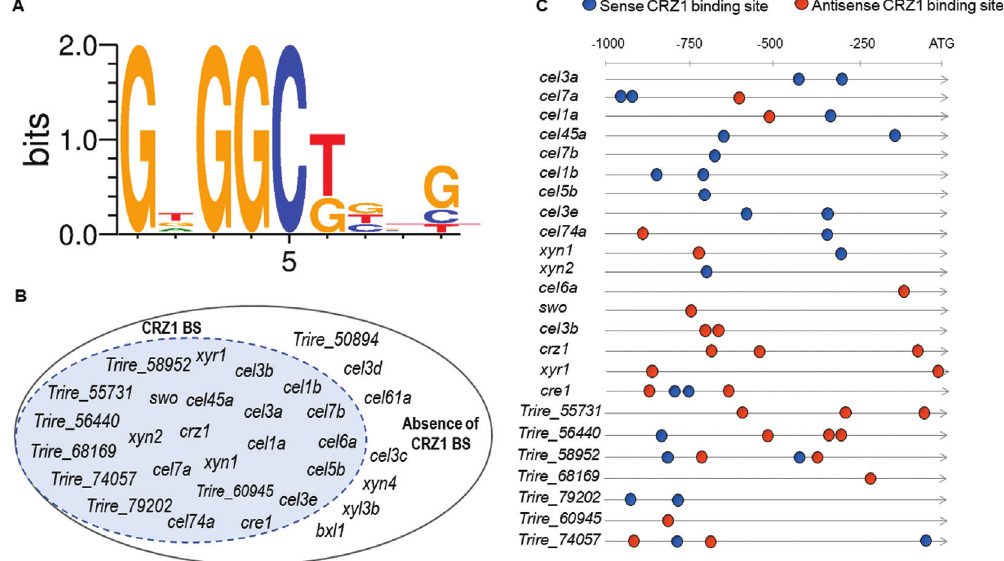
Figure 1 - (A) DNA Consensus sequence of CRZ1 binding in T. reesei obtained through bioinformatics analysis. (B) Representative scheme of genes whichharnessCRZ1BS(CRZ1bindingsites)atgenomiclevel.(C) insilico IdentificationofCRZ1BSinpromoterregionsofholocellulasesandcalcium andsugartransportergenesin T.reesei .Bluespheresindicatethatthosesequences(previouslyshownin1A)havebeenfoundinsenseorientation,andor- ange spheres represent the antisense sequences occurrence. The number of spheres represents the absolute frequency that these sequences were observed in bioinformatics